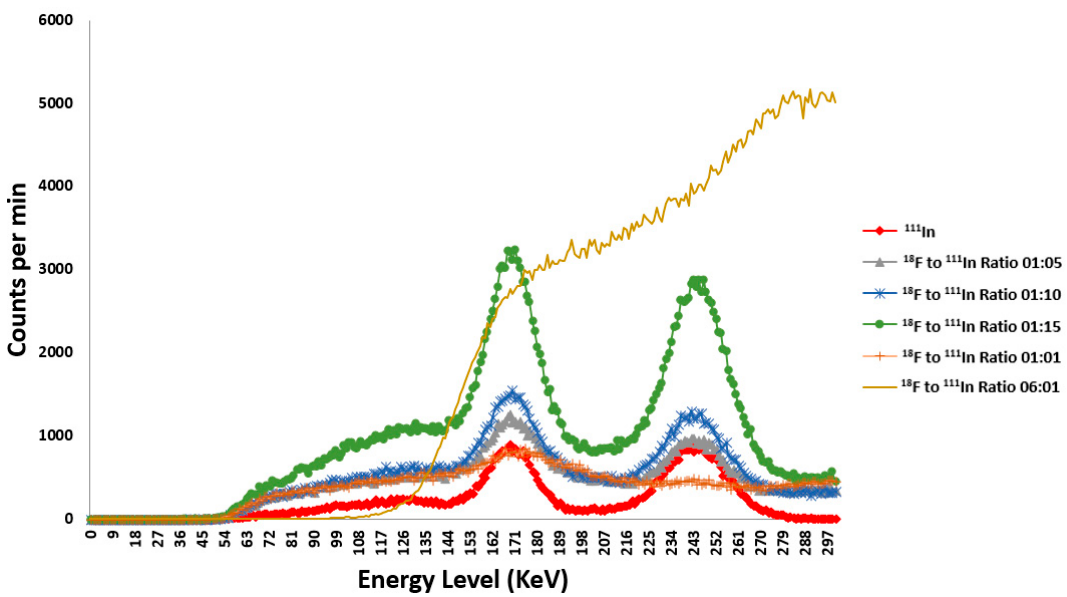
Figure 5. 18 F and 111 In spectrum comparison at different ratios.